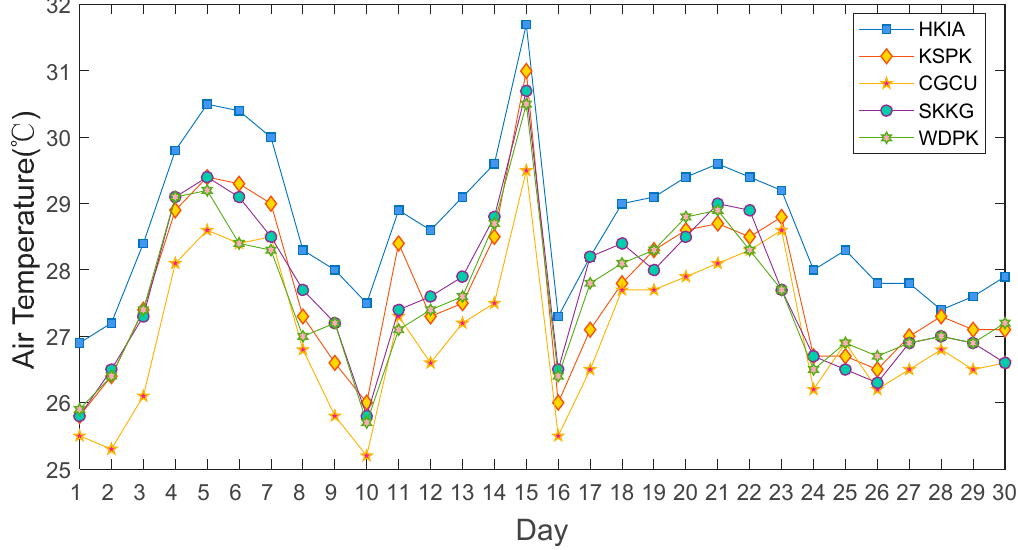
Figure 7. Daily mean temperature over each weather station in September.